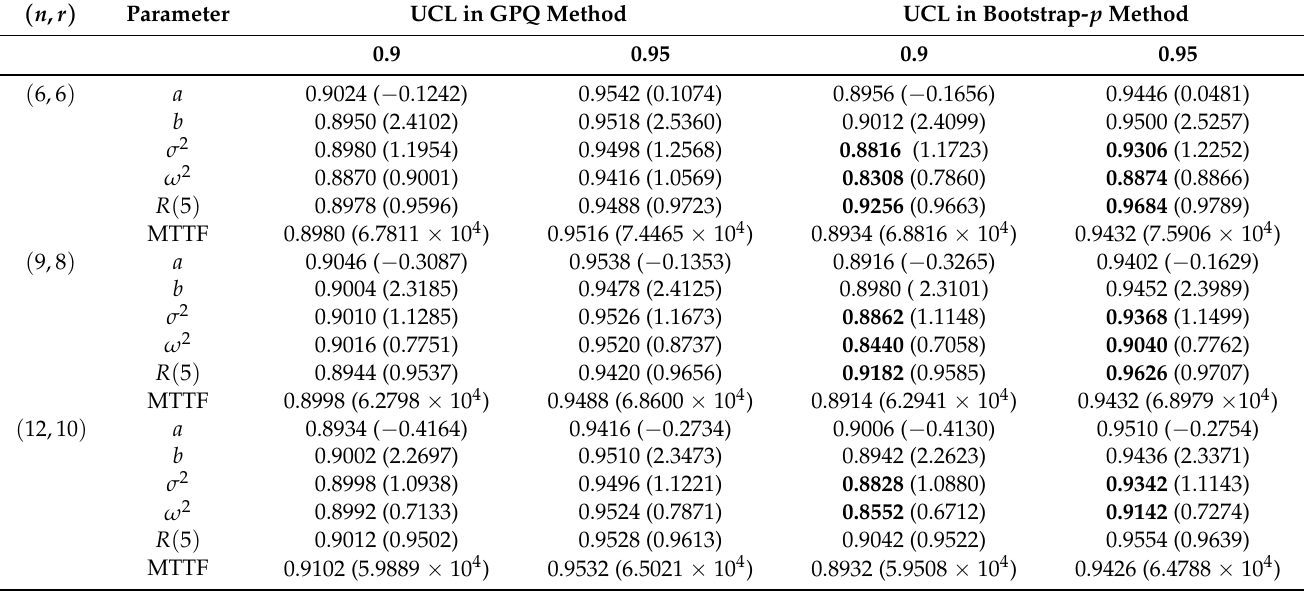
Table 6. The CPs and average values (in parentheses) of different UCLs for model parameters and some quantities under parameter setting I for nominal levels 0.9, 0.95, based on 5000